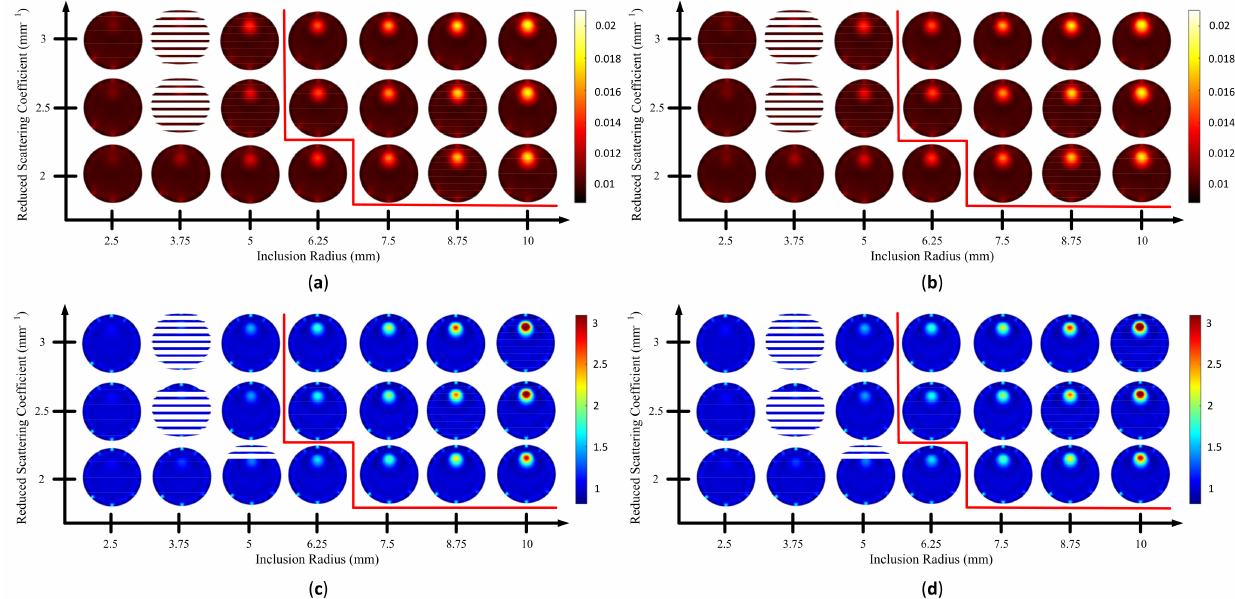
Figure 17. Reconstructed images of case B1 with 1% noise amplitude; red line indicates the invisible ( left side ) and visible ( right side ) inclusions: ( a ) µ a MS-ISSIM-S, ( b ) µ a MOS, ( c ) µ (cid:48) s MS-ISSIM-S, and ( d ) µ (cid:48) s